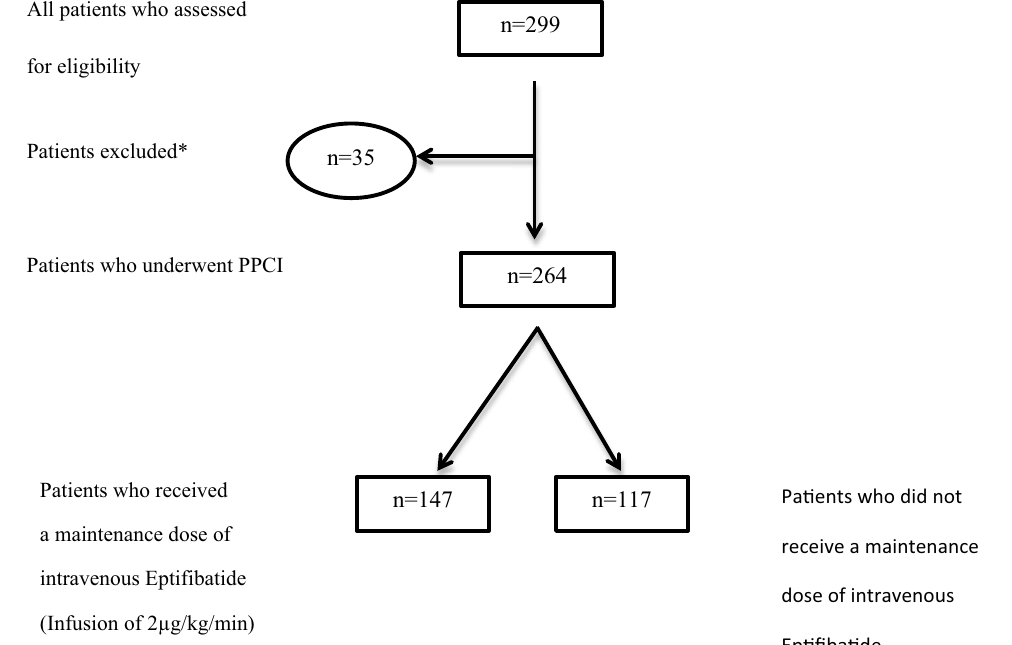
Fig. 1 Clinical trial flowchart. *Patients who presented with cardiogenic shock, patients who became candidates for PCI after receiving fibrinolytics, patients who became candidates for emergent coronary artery bypass graft surgery after angiography, patients under 18 years old or over 80 years old, pregnant patients, patients with kidney or liver failure and patients who had contraindications for Eptifibatide use (see main text, methods, patient selection) were excluded from the study. PPCI: Primary Percutaneous Coronary